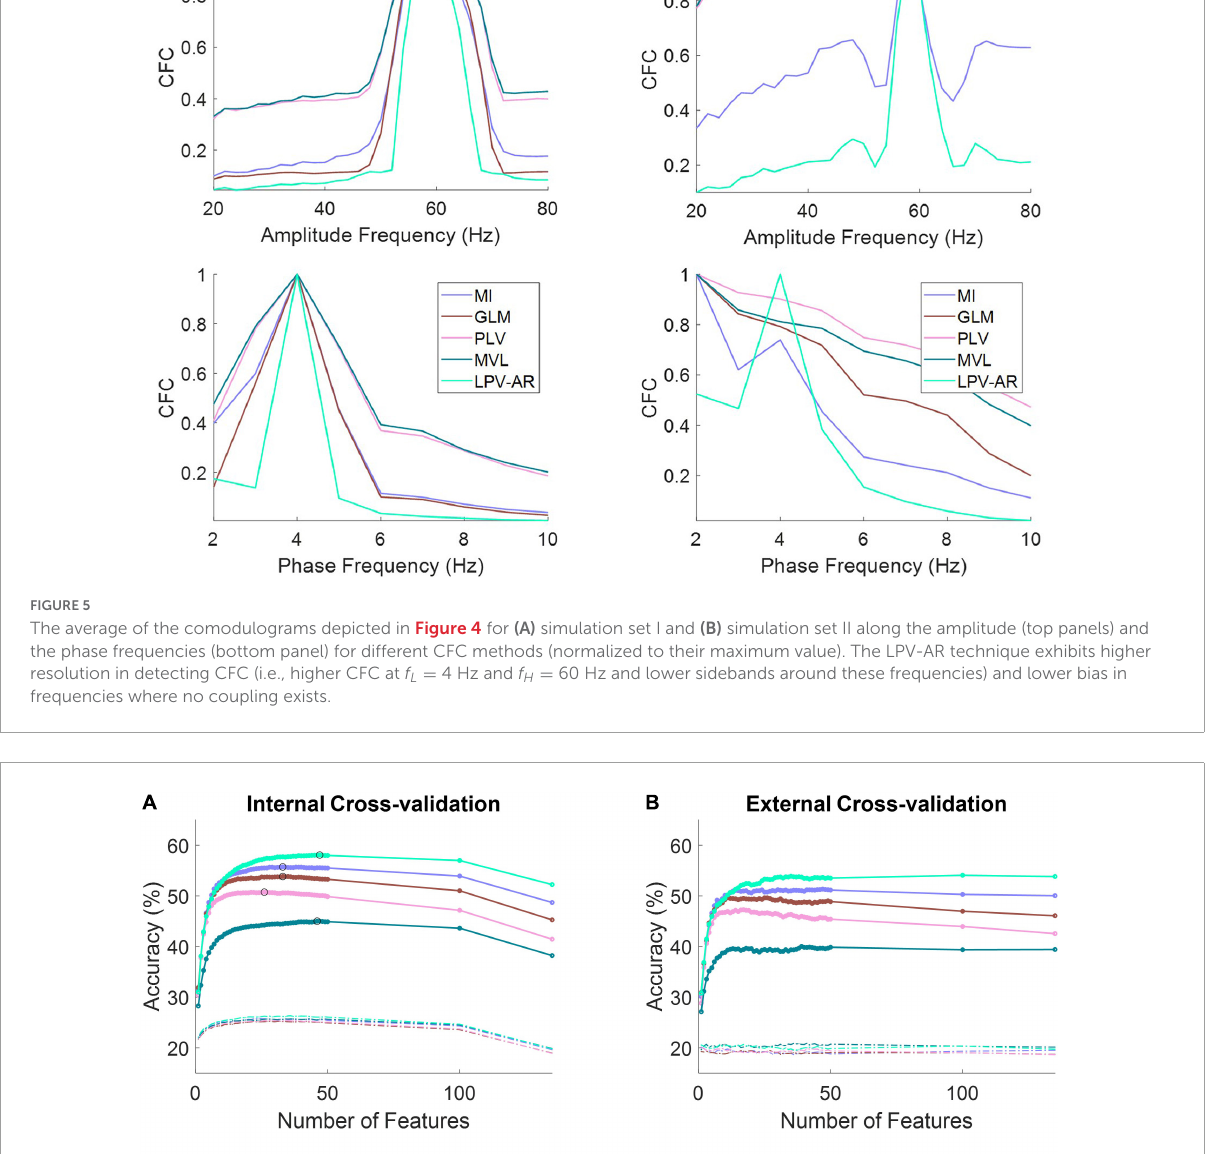
Figure 8 we present the average importance of different ROIs (i.e., the importance of CFC features belonging to a specific ROI, for all low and high frequency band combinations, were